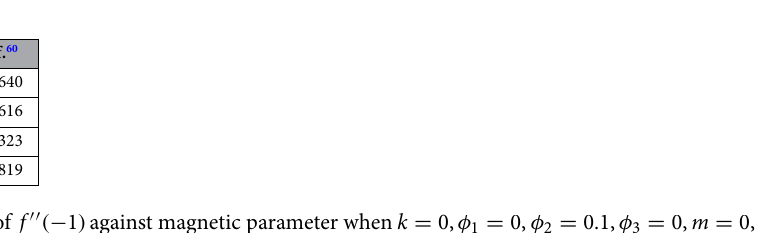
Table 8. Comparison of f ′′ ( and β → ∞